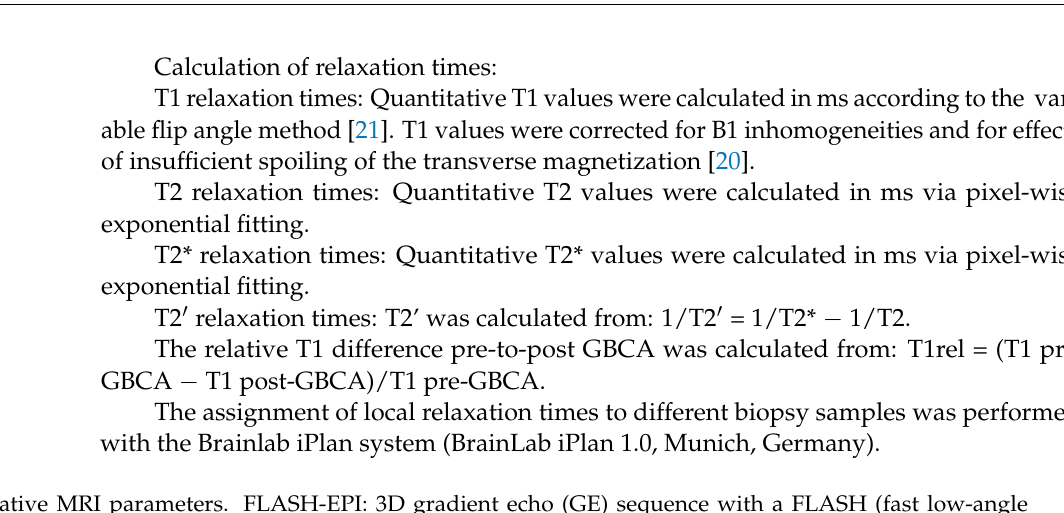
Table 2. Quantitative MRI parameters. FLASH-EPI: 3D gradient echo (GE) sequence with a FLASH (fast low-angle shot)—EPI (echo planar imaging) hybrid readout [17] and fat-insensitive excitation pulses [18]. GBCA: application